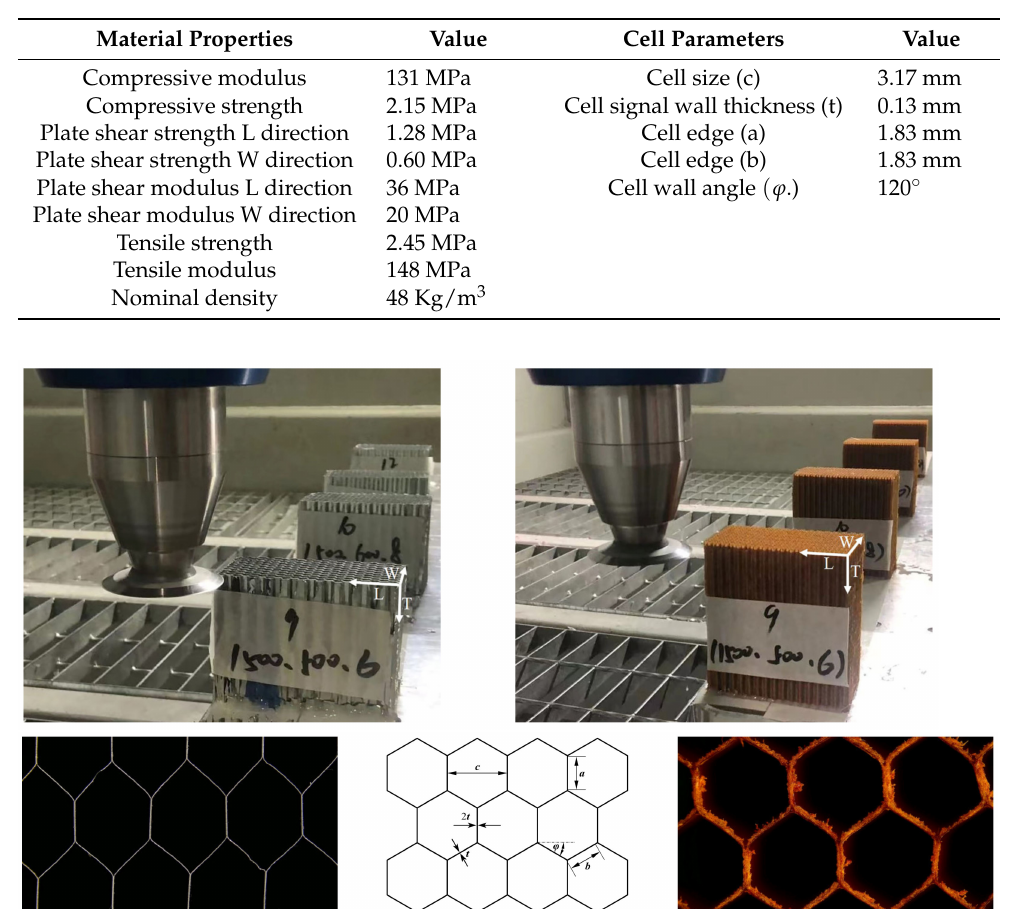
Figure 5. Honeycomb core workpieces and their structural parameters used in this experiment.